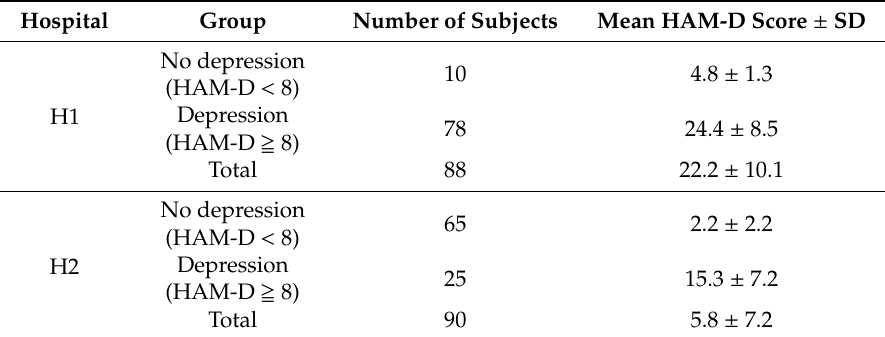
Table 3. Mean scores on the Hamilton Rating Scale for